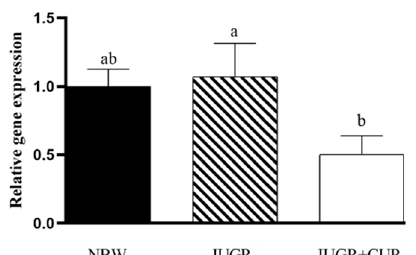
Figure 2. Effects of curcumin on heat-shock protein 70 (hsp70) gene expression in jejunal mucosa. Data are normalized to the NBW group and expressed as mean ± SE (n = 6); a, b means that the same parameter with different superscripts are significantly different ( p < 0.05). NBW: normal-birth weight group; IUGR: intrauterine growth retardation group; IUGR+CUR: intrauterine growth retardation+curcumin group.